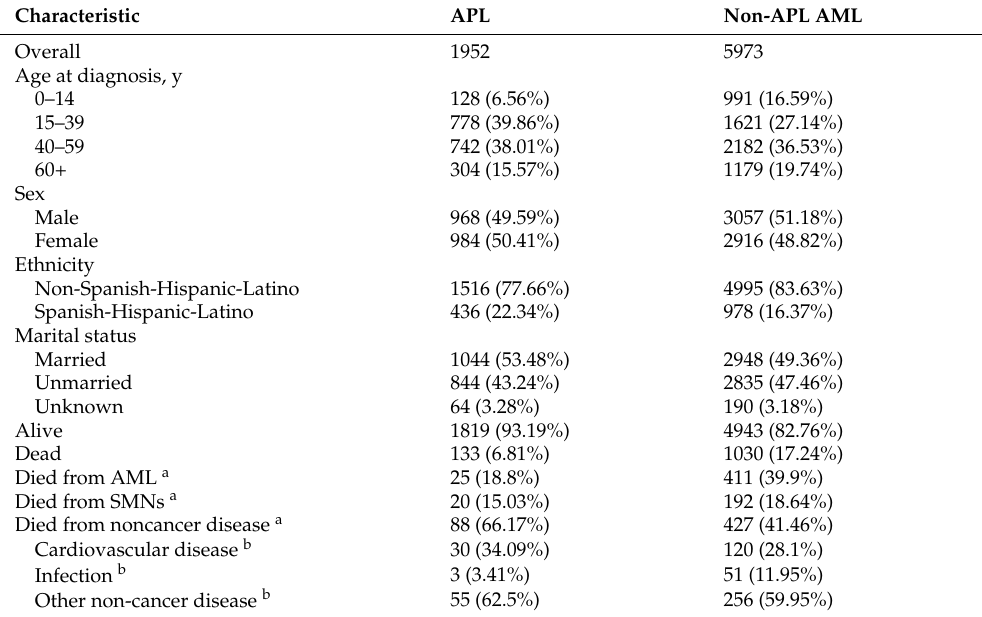
Table 1. Demographics and clinical characteristics of the